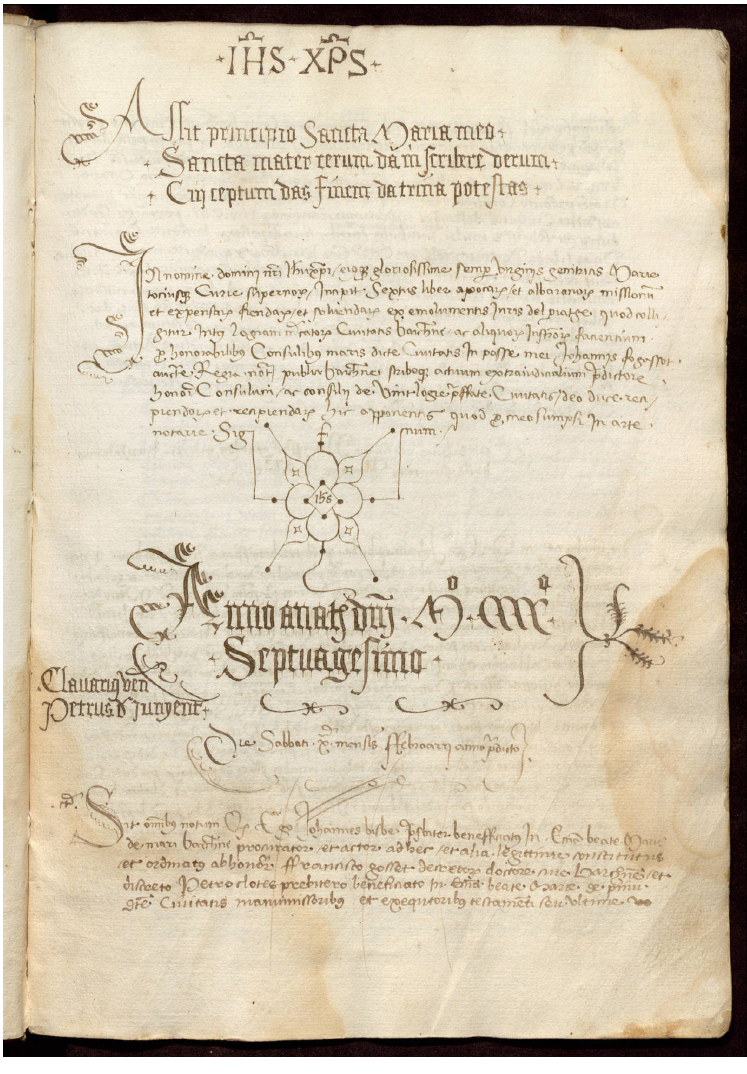
Fig. 4: Barcelona, Biblioteca de Catalunya, JC 144, fol. 1r. Font: Biblioteca de